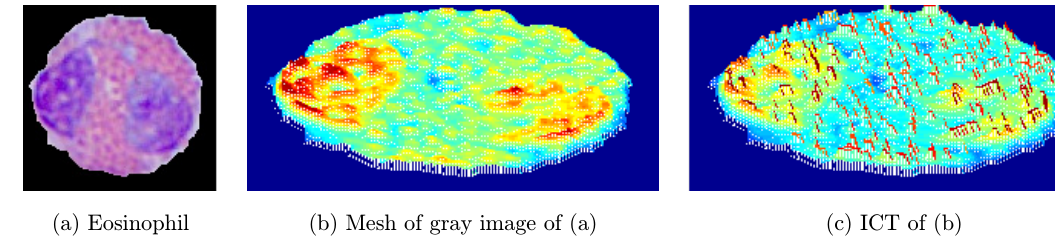
Fig. 5. Clustering of eosinophil.